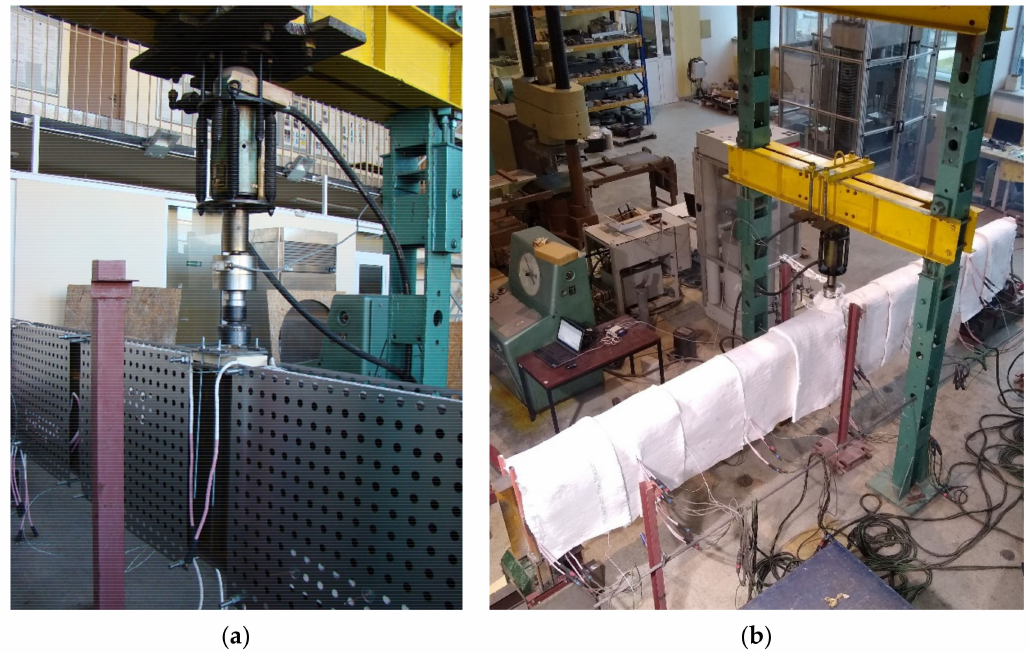
Figure 6. ( a ) The head of the testing machine; ( b ) steel plate girder B1 during the test. The girder displacements have been measured at three points located in beam